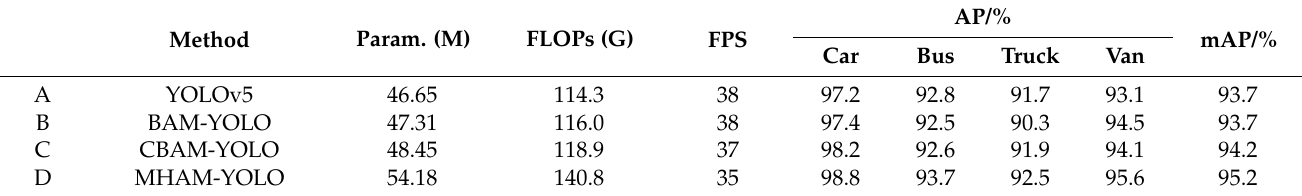
Table 3. Comparison of different attention